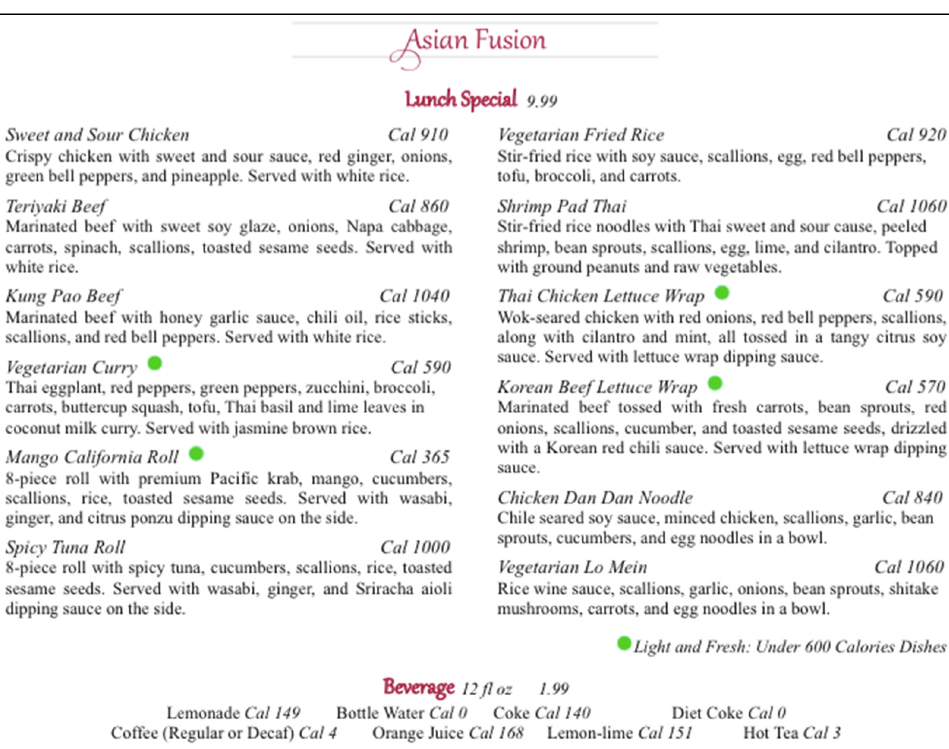
Figure A5. California Cafe Control Menu.